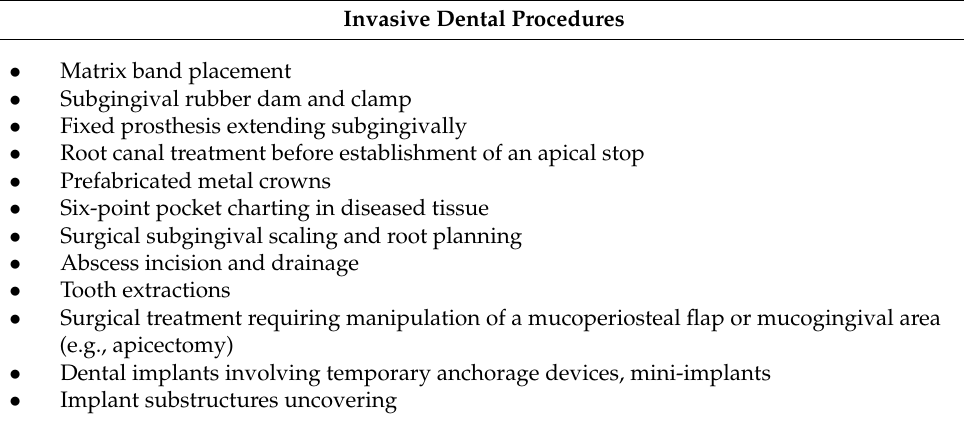
Table 1. Dental procedures which are considered to be invasive